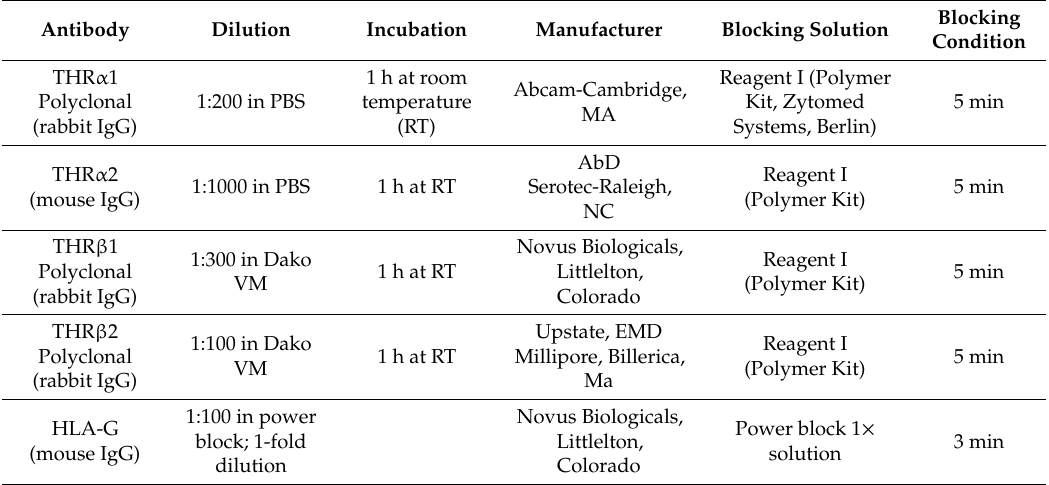
Table 2. Antibodies and dilutions used for immunohistochemistry and double immune